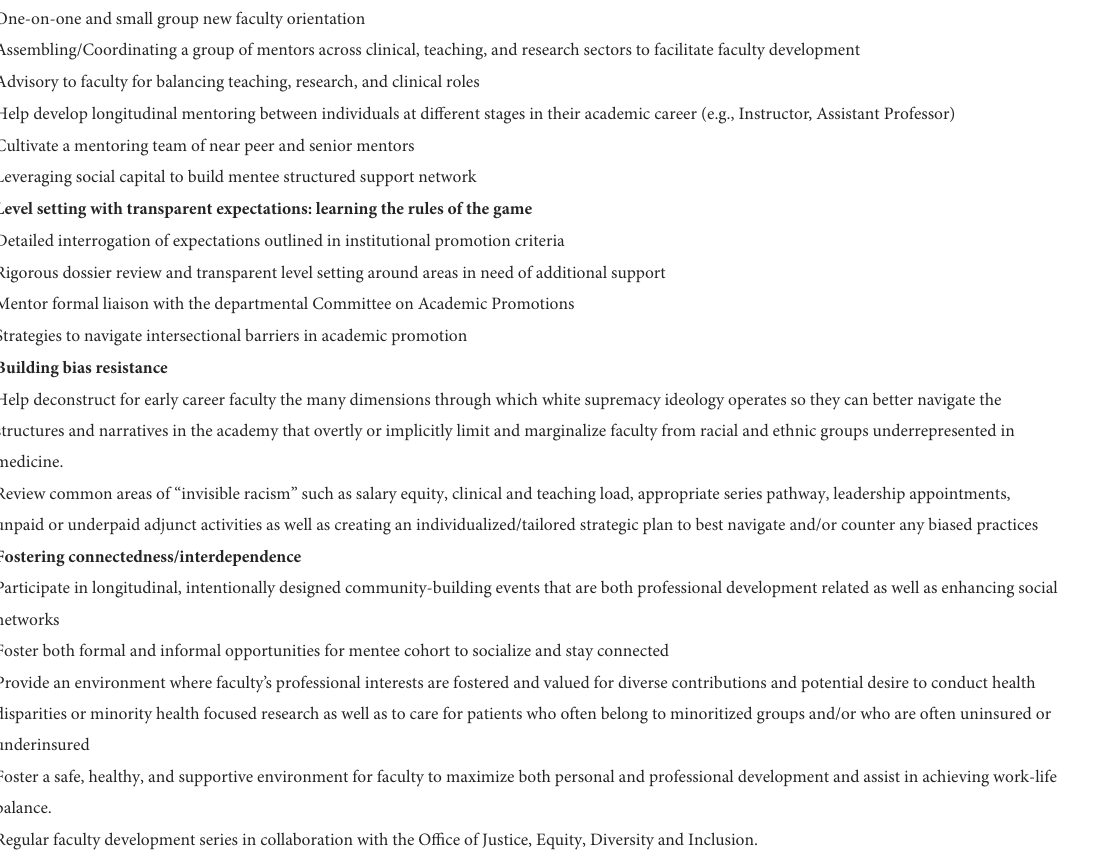
It takes a village: creating a team of sponsorsand